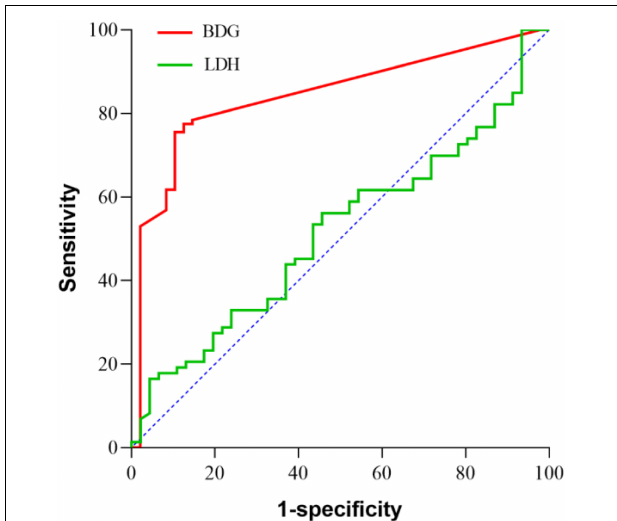
FIGURE 3 | ROC curves for lactate dehydrogenase (LDH), β -D-glucan (BDG). The areas under the curve values are 0.845 (95% CI, 77.8–91.2%, p < 0.001) for BDG and 0.482 (95% CI, 37.6–58.8%, p = 0.744) for LDH. There were significantly differences in the area under the curve value between BDG and LDH ( p <